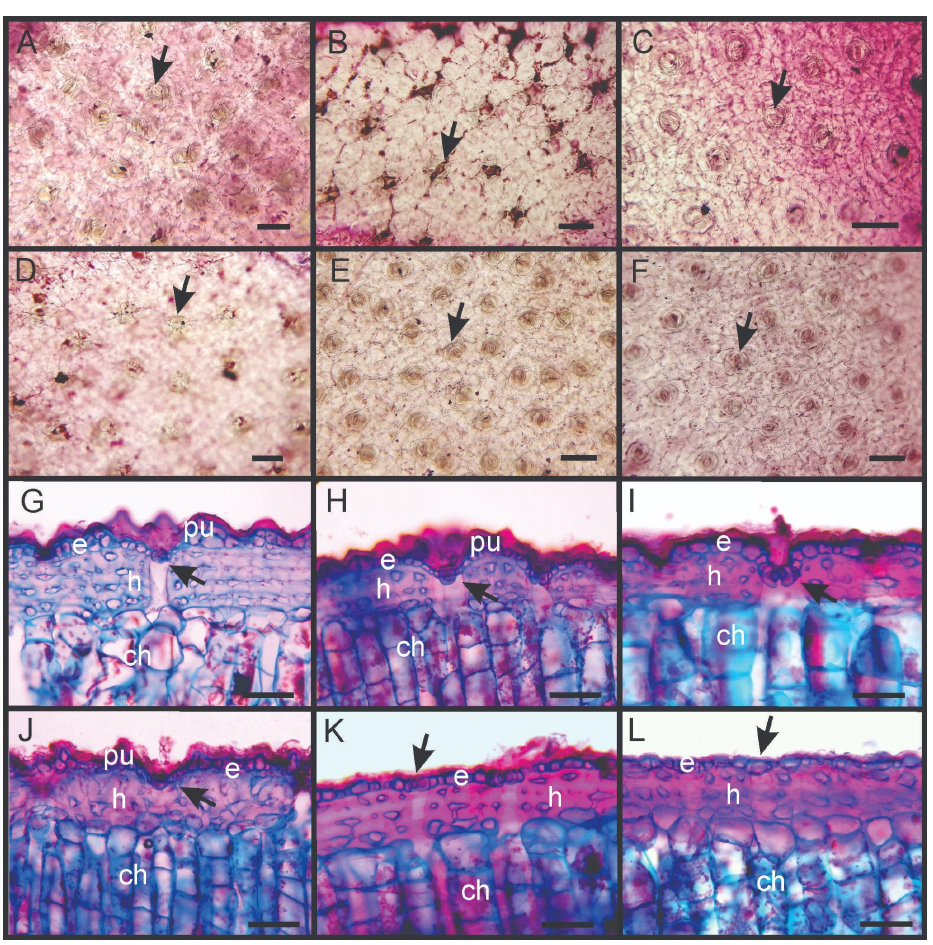
Figure 4. Stem anatomy in Gymnocalycium species. ( A – F ): Epidermis in surface view. Sunken stomata with cuticle ridges and pustules in ( A – D ). Stomata at the same level in ( E , F ). ( G – L ): Epidermal system and chlorenchyma in transverse section. Epidermis with pustules, irregular cuticle thickening and sunken stomata in ( G – J ). Thin and homogeneous epidermis and cuticle, stomata at the same level in ( H , I ). ( A , G ): G. pugionacanthum ; ( B , H ): G. hybopleurum, ( C , I ): G. oenanthenum and ( D , J ): G. stellatum